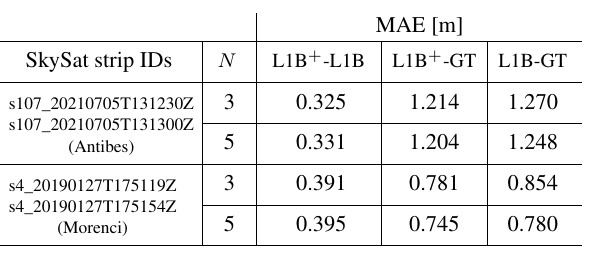
Table 1. Quantitative results of the stereo reconstruction based evaluation, using 3 or 5 scenes from the input strips. Left to right: MAE, in meters, between the L1B + and L1B derived DSMs, and MAE of each DSM with respect to a GT lidar